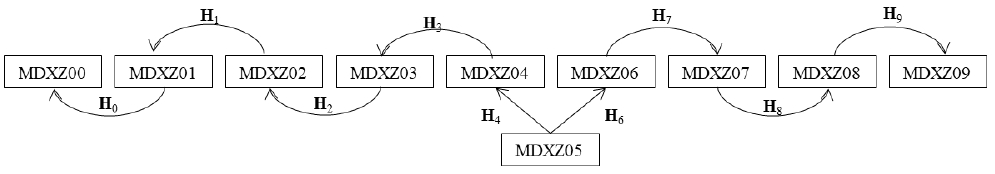
Figure 11. The relationship between video frames when using Strategy-A.